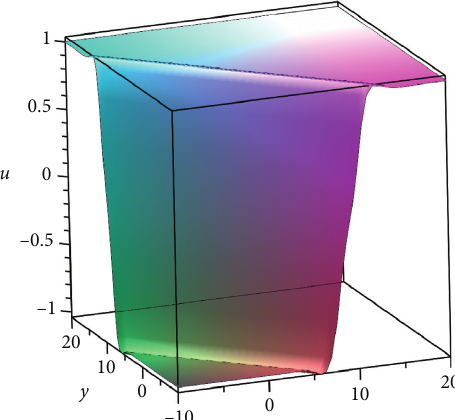
Figure 1: Spatiotemporal structure of solution (9) with parameter � 1, a � 1, and α � 1. selections a 1 5